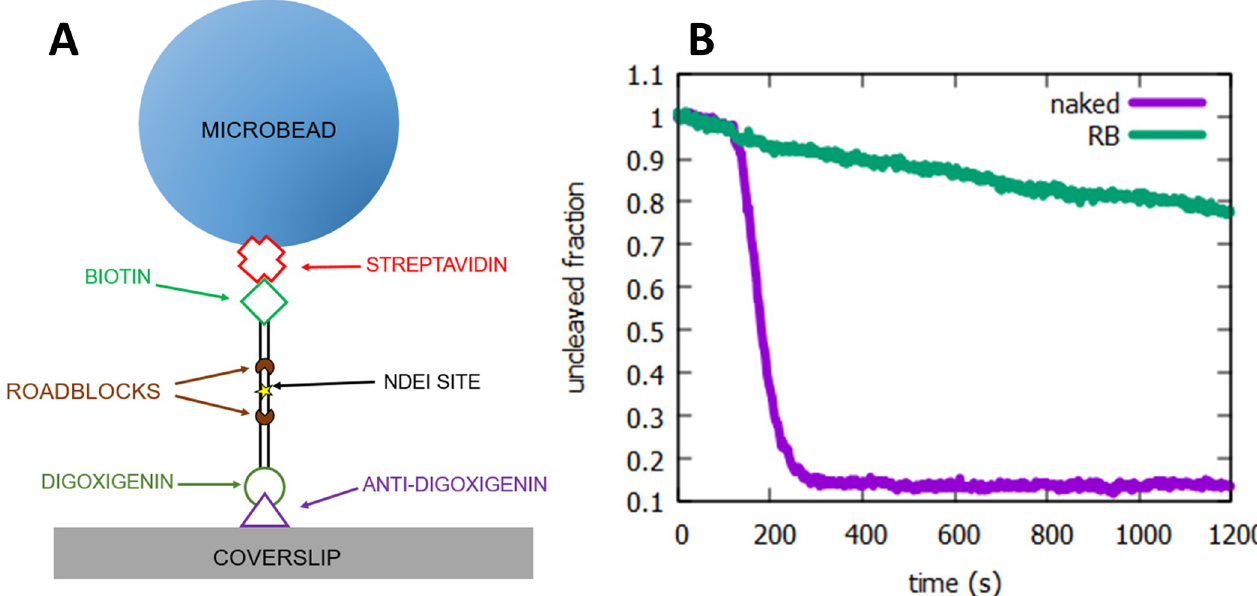
Fig 2. Complete binding of roadblock. (A) Schematic showing DNA tethers with the locations of NdeI cognate and roadblock sites indicated. BtgI sites are contained within the roadblock sites. (B) Plot of fraction of uncleaved DNA versus time after injection of BtgI is shown. Purple curve is naked DNA without roadblocks. Rapid decrease at 180s is due to cleavage of the internal BtgI site contained in the roadblock sequence. Green curve is DNA with roadblocks. No cleavage is observed after injection of BtgI (180s). The gradual decrease over time is due to DNA tethered beads detaching from the surface non-specifically, and not due to DNA